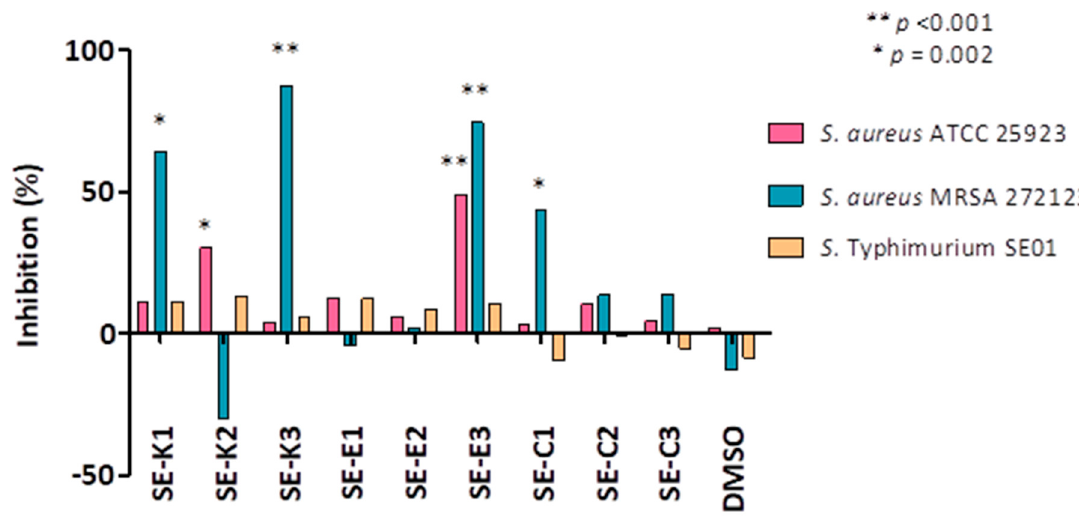
Figure 3. Anti-biofilm effect of Se-compounds on S . Typhimurium SE01 wild-type and on sensitive and resistant S. aureus strains. The levels of significance were ** p < 0.001 and * p = 0.002, respectively.